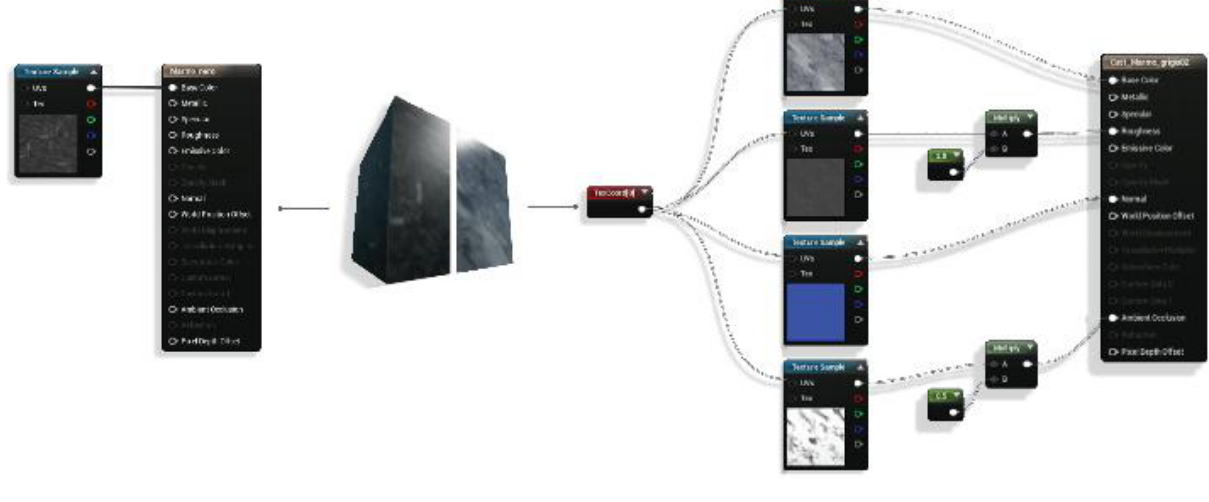
Figure 10: Unreal Engine, a base material and an optimized